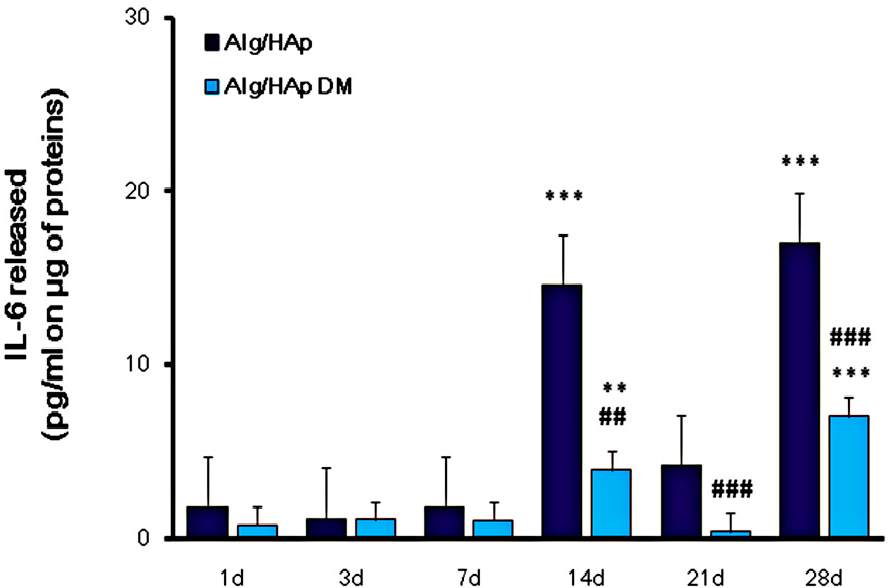
Figure 4. Interleukin-6 (IL-6) released from DPSC growth onto Alg / HAp sca ff olds. The bar graph displays the quantification of IL-6 released in pg / mL normalized to the protein content ( µ g / sample). Figure 4 . Interleukin-6 (IL-6) released from DPSC growth onto Alg/HAp scaffolds. The bar graph Values are expressed as means ± SEM ( n = 3). ** p < 0.01 between Alg / HAp at three days and Alg / HAp displays the quantification of IL-6 released in pg/mL normalized to the protein content ( μ g/sample). at one day; ** p < 0.01 between Alg / HAp with DM at three and 14 days and Alg / HAp at one day; Values are expressed as means ± SEM ( n = 3). ** p < 0.01 between Alg/HAp at three days and Alg/HAp *** p < 0.005 between Alg / HAp at 14 and 28 days and Alg / HAp at one day; *** p < 0.005 between at one day; ** p < 0.01 between Alg/HAp with DM at three and 14 days and Alg/HAp at one day; *** Alg / HAp with DM at 28 days and Alg / HAp at one day; ## p < 0.01 between Alg / HAp with and without p < 0.005 between Alg/HAp at 14 and 28 days and Alg/HAp at one day; *** p < 0.005 between Alg/HAp DM at 14 days; ### p < 0.005 between Alg / HAp with and without DM at 28 with DM at 28 days and Alg/HAp at one day; ## p < 0.01 between Alg/HAp with and without DM at 14 days; ### p < 0.005 between Alg/HAp with and without DM at 28 days.